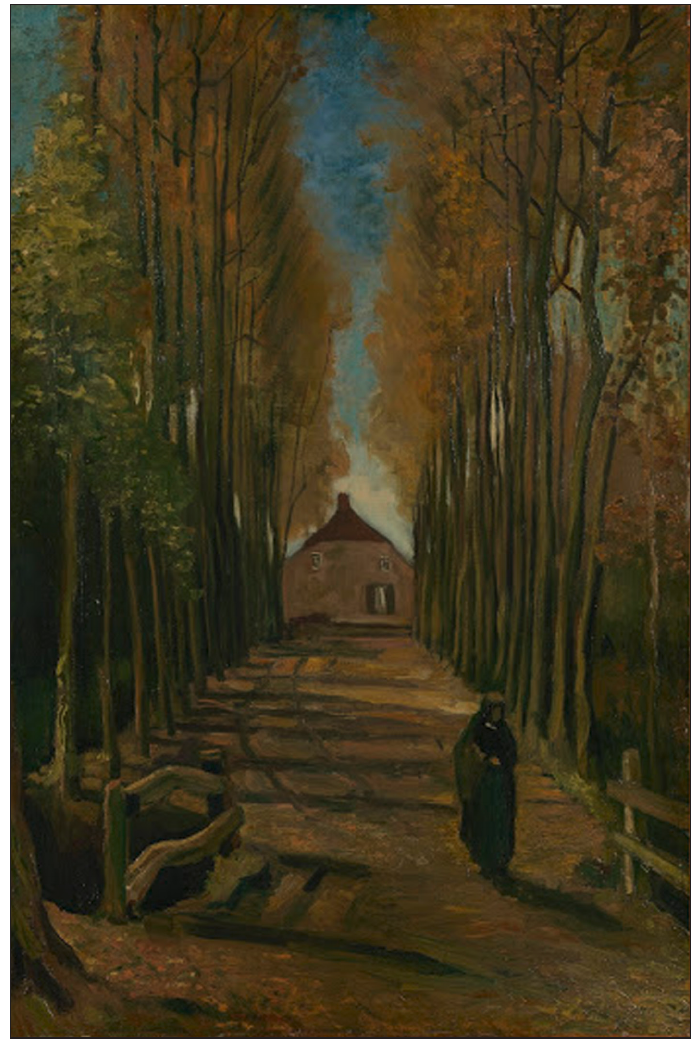
Fig. 5 : Vincent Van Gogh, Avenue of Poplars in Autumn , 1884, oil on canvas on panel, 99 × 65.7 cm. Credit: Van Gogh Museum, Amsterdam (purchased with support from the Vincent van Gogh Foundation and the Rembrandt